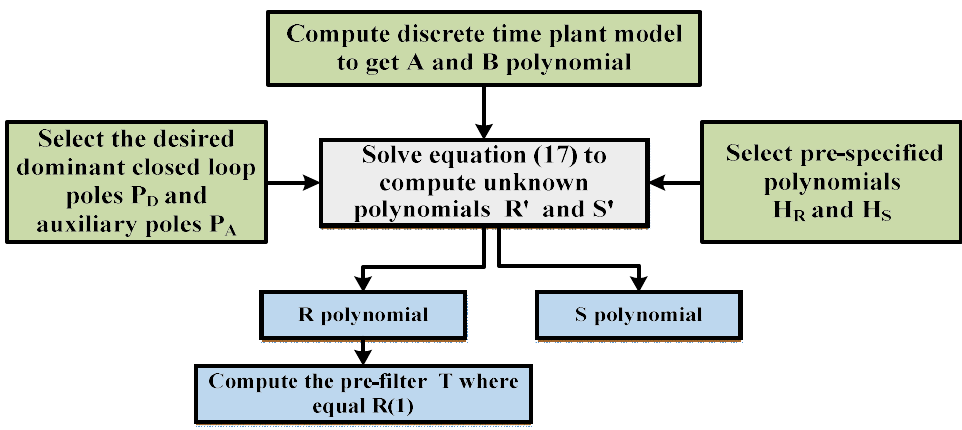
Figure 5. Block diagram of the controller design steps.